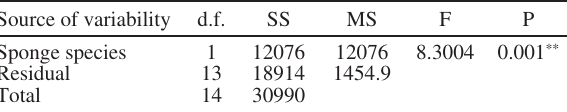
Table 4. – Summary of results of one-way PERMANOVA for the associated fauna of the two sponge species. Analyses were